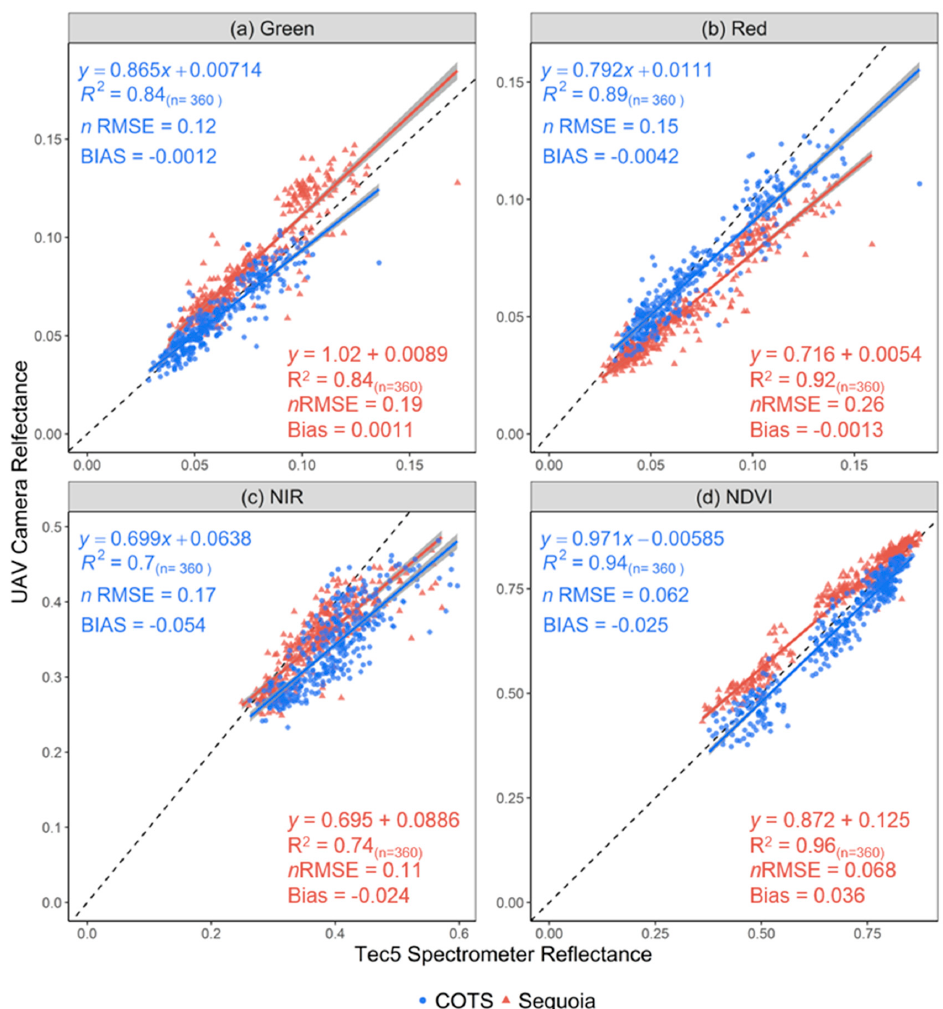
Figure 16. Comparison of accuracies achieved by COTS (blue) cameras and Parrot Sequoia (red) in ( a ) green, ( b ) red and ( c ) NIR reflectance and ( d ) NDVI. Comparisons are made against Tec5 measure reflectances and NDVI. Reflectance was measured from both cameras on the same date (21 June 2017), whilst Tec5 measurements were collected two days later. The dashed line represents the 1:1 line.